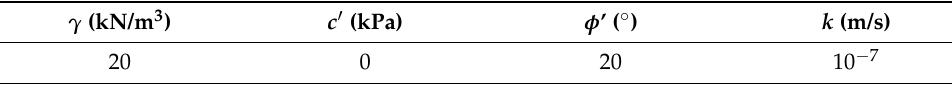
Table 4. Soil properties of the embankment (data from